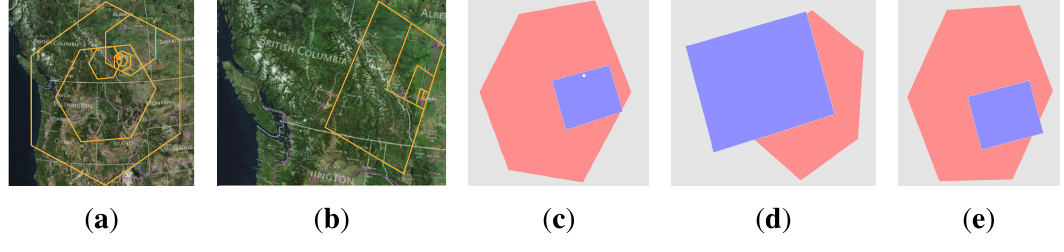
is the 2 and S are overlapped ( d ) The 1 2 and S . 1 2